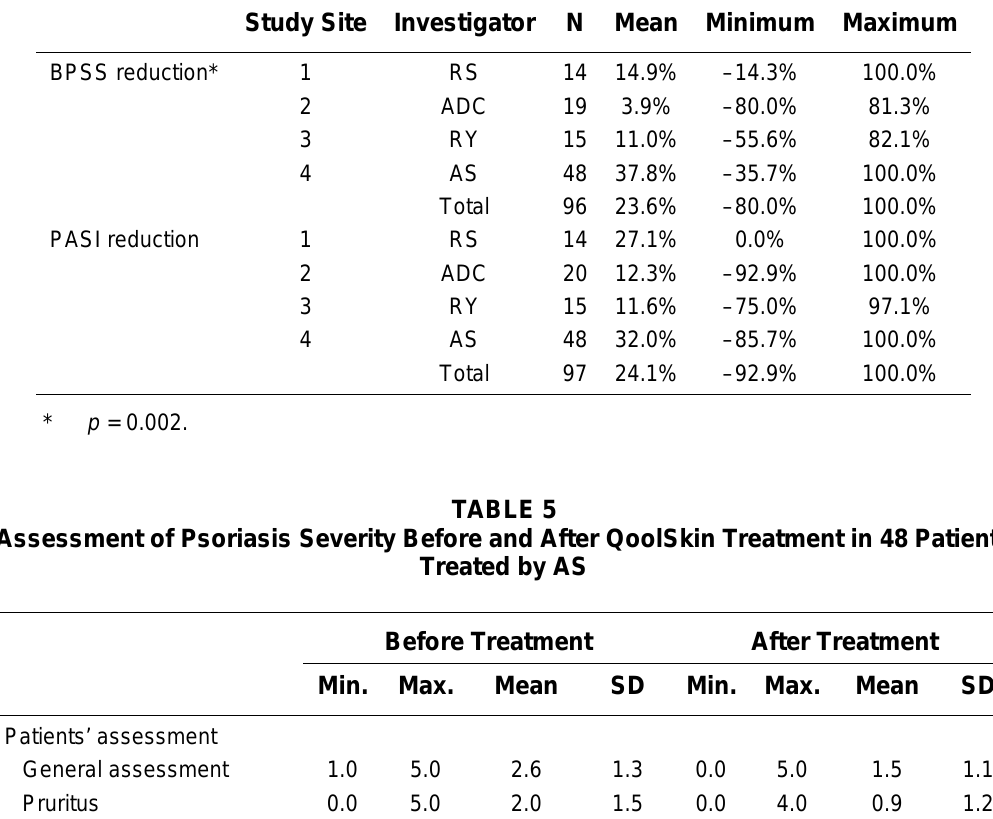
Assessment of Psoriasis Severity According to the Treating Investigator